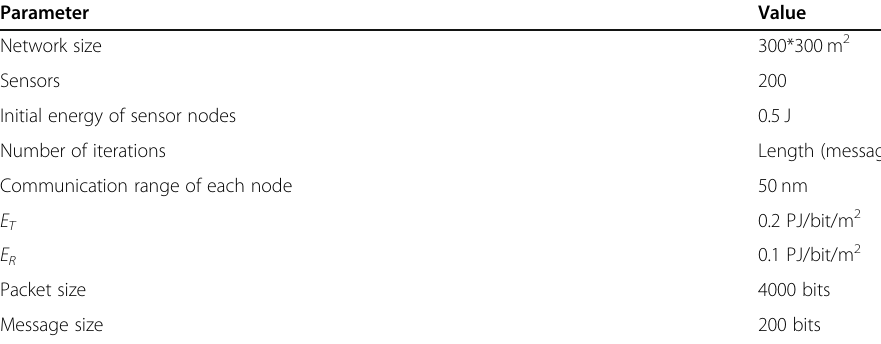
Table 1 Simulation parameters